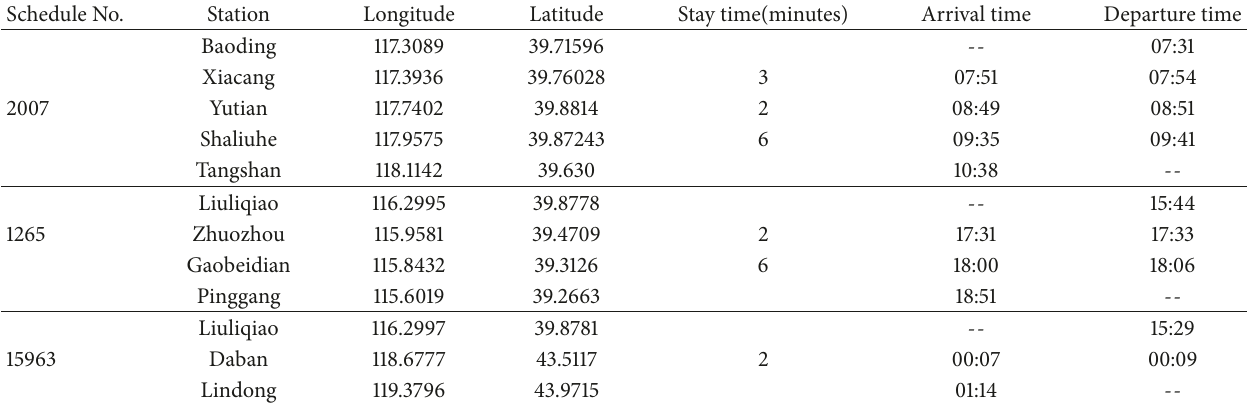
Table 5: Schedules for part of coach